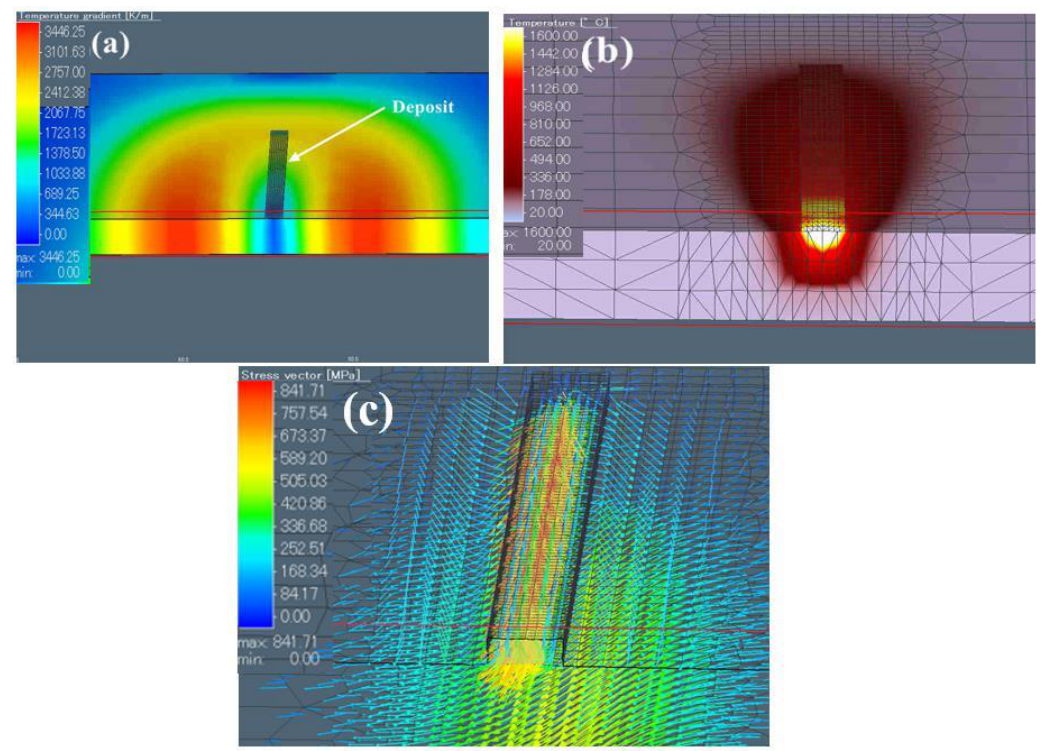
Figure 10. ( a ) The distribution of temperature, ( b ) the molten pool, and ( c ) the distribution of residual stress in a cross-section of the single-bead part.